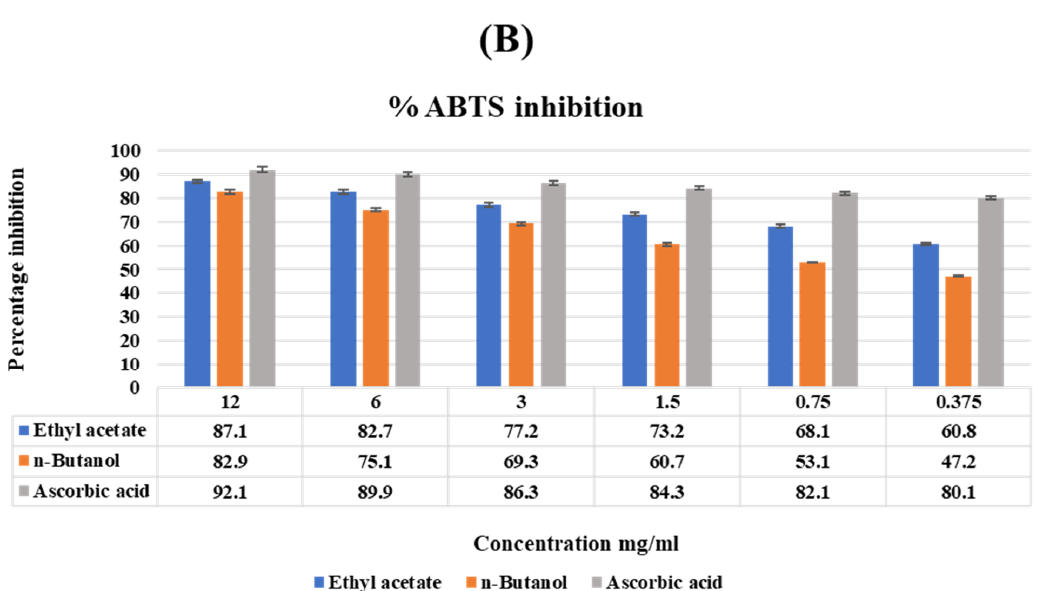
Figure 4. ( A ) Antioxidant activity of fractions of T. vulgaris through the DPPH assay. ( B ) Antioxidant activity of fractions of T. vulgaris through the ABTS assay. Vertical bars represent the mean ± S.E. The values are expressed in the mean ± SD of triplicates, and all values were statistically significant at p < 0.05.